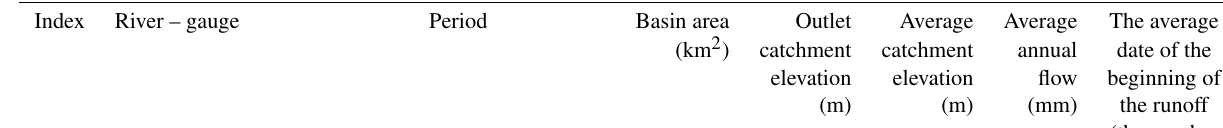
Table 1. Characteristics of runoff gauge